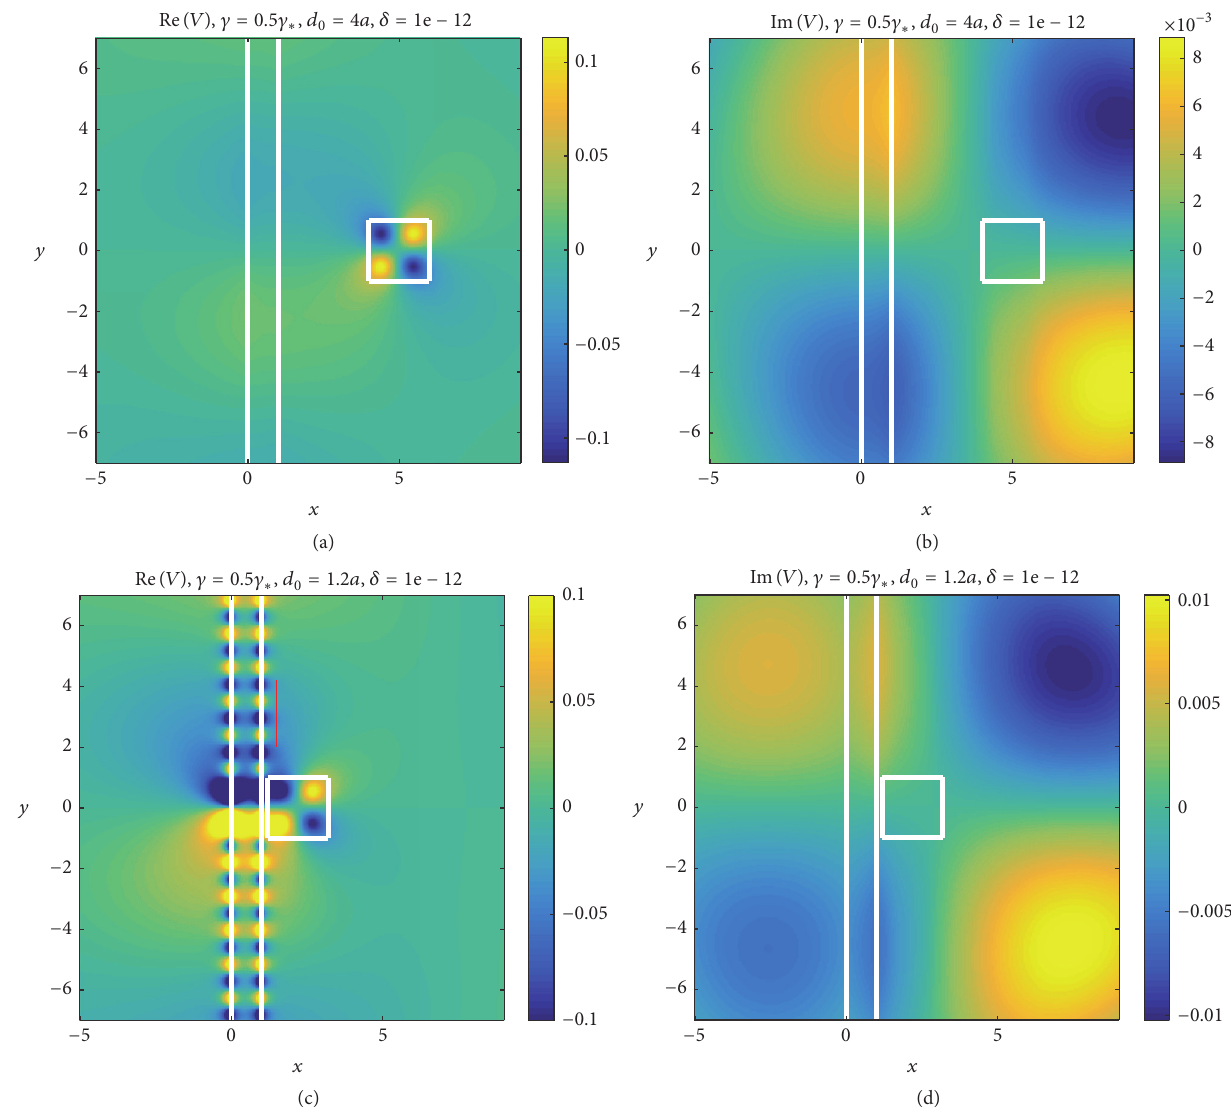
Figure 8: This is a plot of 𝑉 , the solution to (4), when 𝑓 is the function in (49) and 𝛾 = 0.5𝛾 ∗ : (a) Re (𝑉) and (b) Im (𝑉) for 𝑑 0 = 4𝑎 ; (c) Re (𝑉) and (d) Im (𝑉) for 𝑑 0 = 1.2𝑎 . To make the behavior of Re (𝑉) clearer, in (a) and (c) we clipped the maximum and minimum values in each plot to 0.1 (yellow) and −0.1 (blue), respectively. The vertical red line in (c) extends a distance of 2𝜆 𝛾 , where 𝜆 𝛾 is defined in